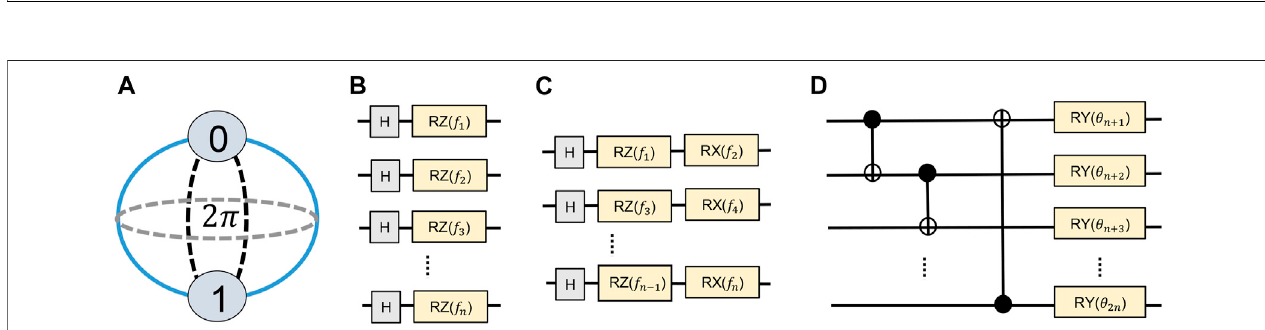
FIGURE2|(A) Blochsphererepresentationofaqubit.Atanygivenpoint,aqubitcanberotatedalongtheX,Y,orZaxis.Thestatesrepeatin2 π intervals, (B) angle encoding1:1(i.e.,onecontinuousvariableencodedinasinglequbitstate), (C) angleencoding2:1(i.e.,twocontinuousvariablesencodedinasinglequbitstate),and (D) parametric layer used in this work (following [7, 8,